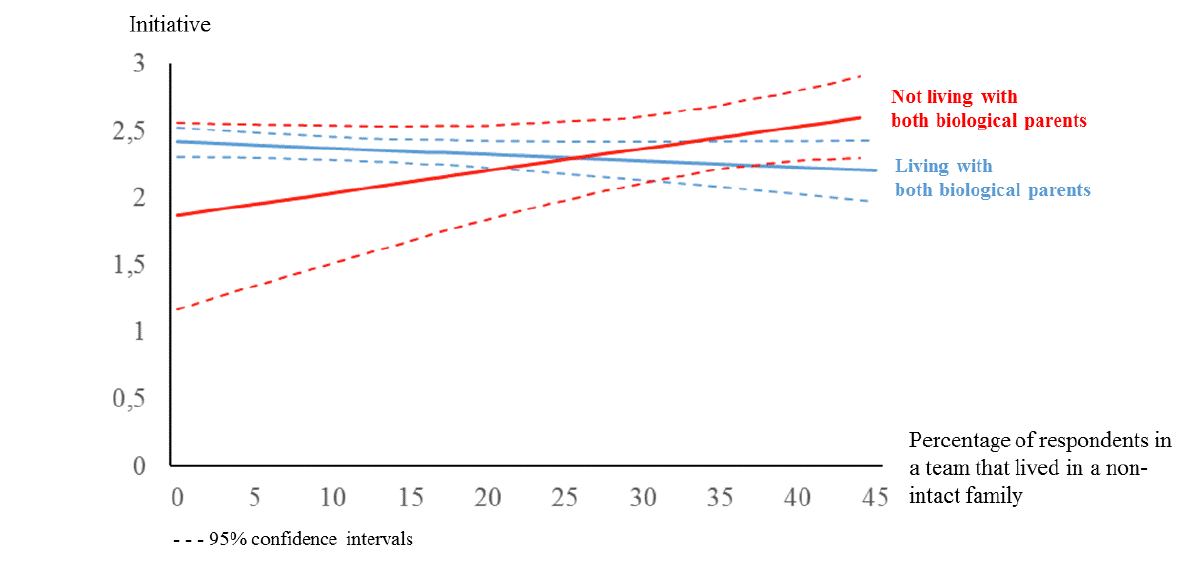
Figure 3 . Interaction effect for initiative between the respondents’ family structures on the participant level and team